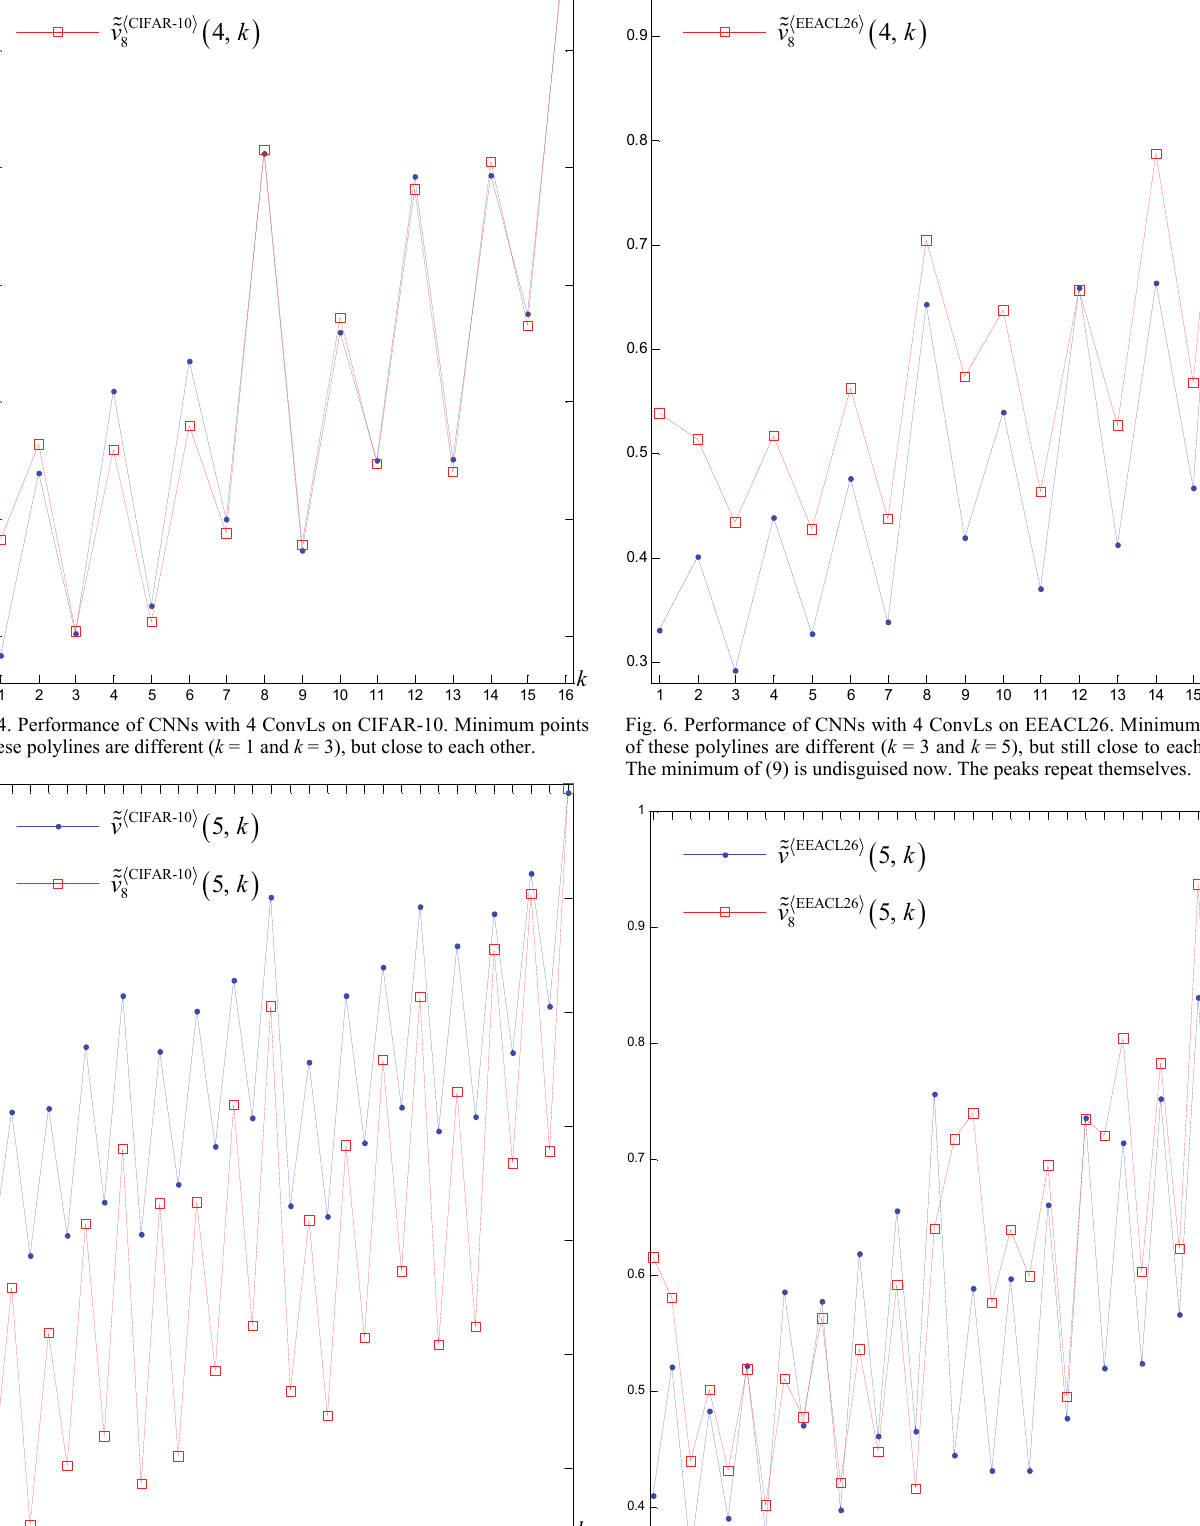
Fig. 5. Performance of CNNs with 5 ConvLs on CIFAR-10. Minima coincide corresponding to 00010 . The peaks at 8 k  and 16 k  remind those ones   2 in Fig. 4. Inserting all possible 5 DOLs at once is the worst version similarly.